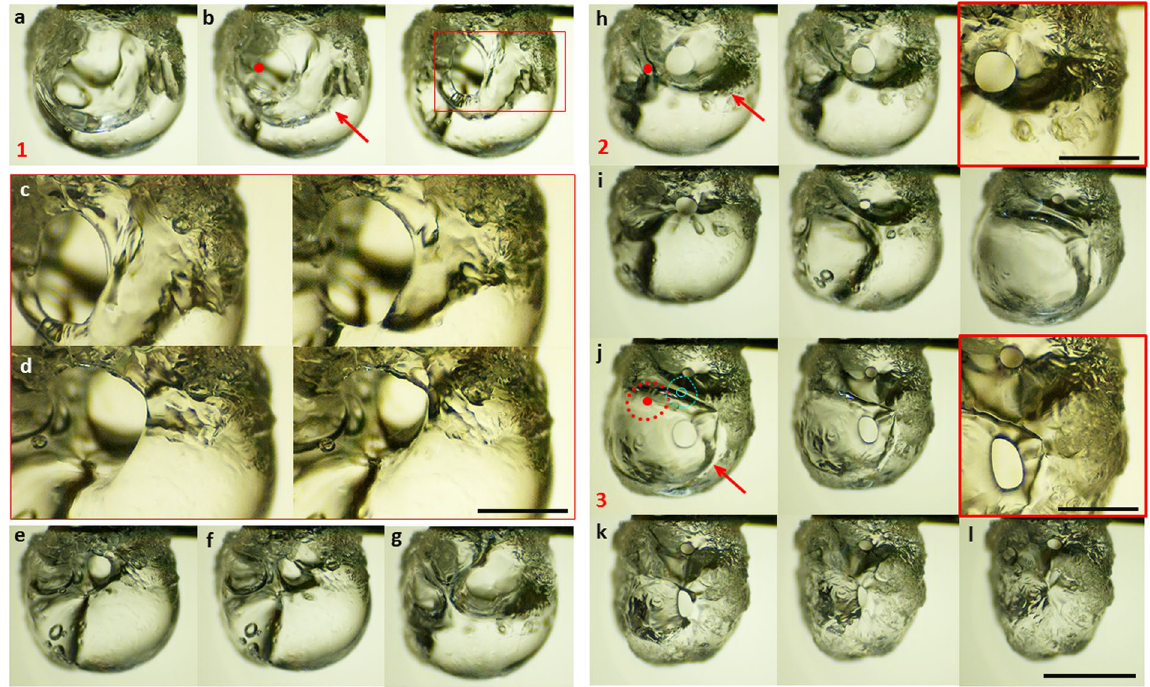
Figure 1. Dynamic rupture sequence of a burning organic gellant (3 wt.% HPMC) based ethanol fuel droplet undergoing an oscillatory jetting cascade with three cycles. Cycle 1: ( a ) Swelled droplet state; t = 0 ms, ( b ) First gellant layer rupture leading to jet hole formation; 0.834 and 1.527 ms. Red dot indicates the initial rupture location. Red arrow marks the feeder bubble that acts as a source of unreacted fuel vapor during jetting. ( c ) Magnified view showing jet hole expansion following initial rupture; 1.945 and 4.027 ms, ( d ) magnified view of jet hole during retraction; 8.612 and 12.361 ms, ( e ) continued retraction; 15.416 ms, ( f ) complete recovery of ruptured site; 86.667 ms and ( g ) bubble growth leading to pressure build-up; 88.194 ms. ( h ) Second rupture leading to droplet deflation and marking onset of Cycle 2; 88.75, 89.305 and 89.723 ms. ( i ) Continual shrinkage and displacement of the active jetting site alongside pressure build-up through bubble growth in the bottom hemisphere; 92.916, 131.112 and 388.055 ms. ( j ) Third rupture leading to simultaneous jetting through two active sites (Cycle 3); 388.75, 389.723 and 391.527 ms. Weak soft region of the droplet surface is shown superimposed. ( k ) Continuous shrinkage of bottom jetting site alongside sustained jetting from top jetting hole; 393.612 and 397.778 ms. ( l ) complete recovery of bottom site but sustained jetting from top; 403.334 ms. Images ( a ) to ( f ) and ( h ) to ( l ) constitute the active jetting t period while ( f ) to ( g ) form the inactive or pressure build-up period t . a ia The scale bars equal 1 mm and 0.5 mm for images with overall view and magnified view